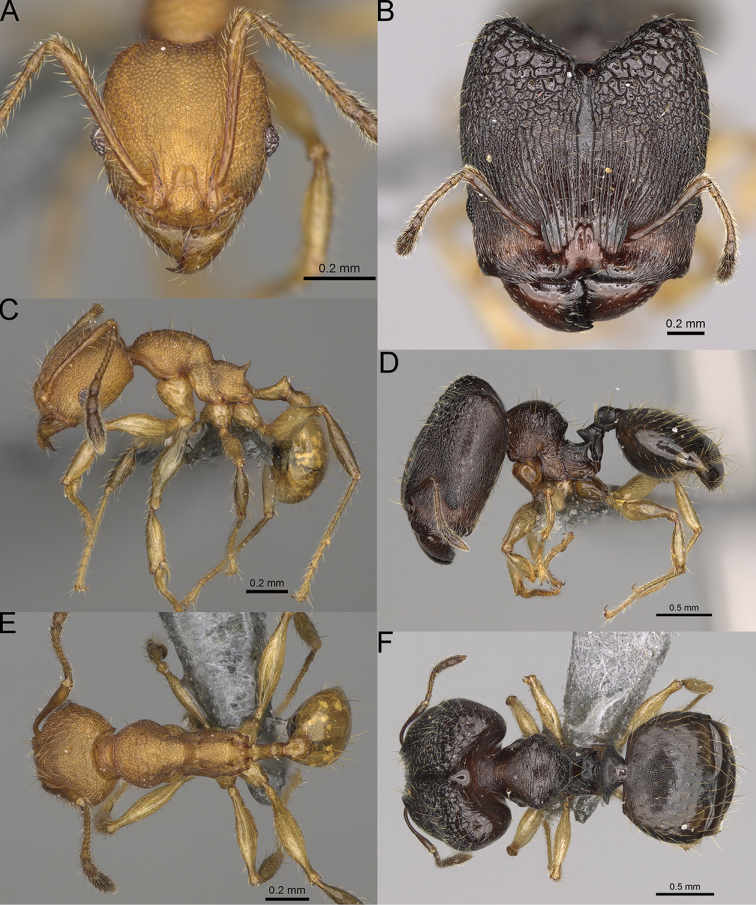
Pheidole
goavana sp. nov., full-face view (A), profile (C), and dorsal view (E) of paratype minor worker (CASENT0923176) and full-face view (B), profile (D), and dorsal view (F) of holotype major worker (CASENT0374538).